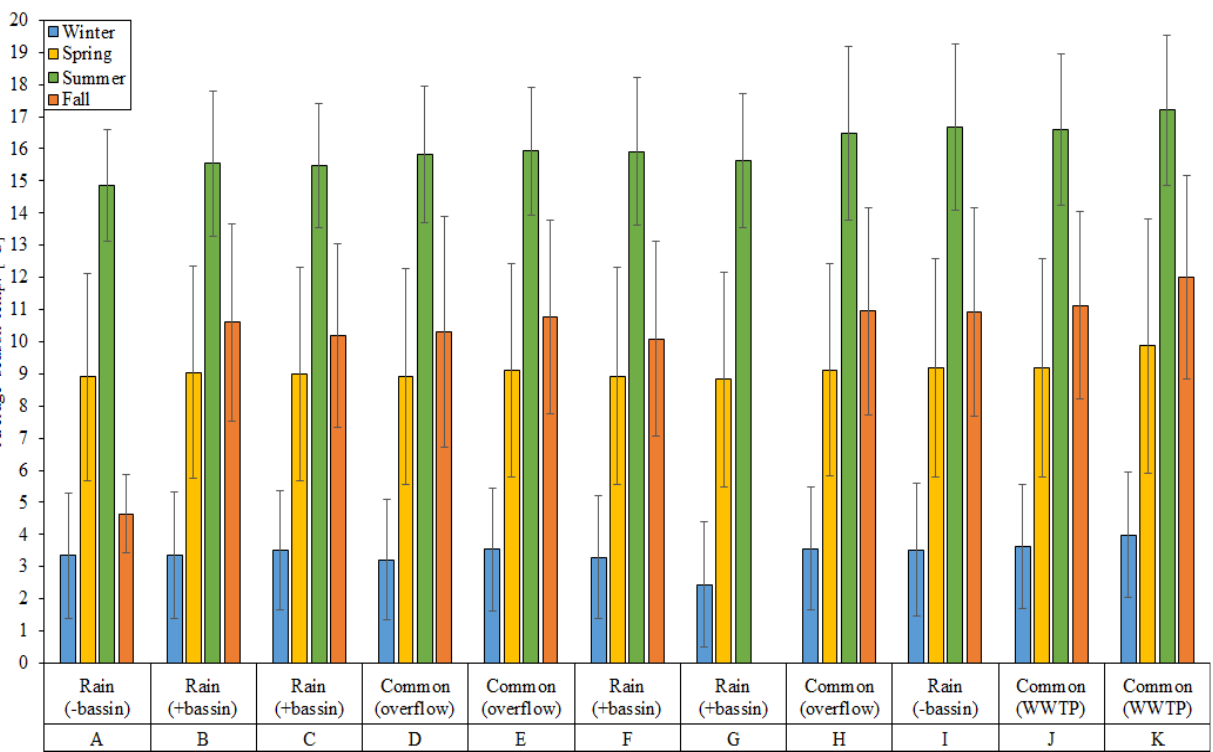
Figure 6. Average water temperature at each station (A–K) pr. season: winter (blue), spring (yellow), summer (green), and fall (orange). Each station is listed with the nearest upstream outlet type: rain (-basin), rain (+basin), and common (overflow and WWTP).